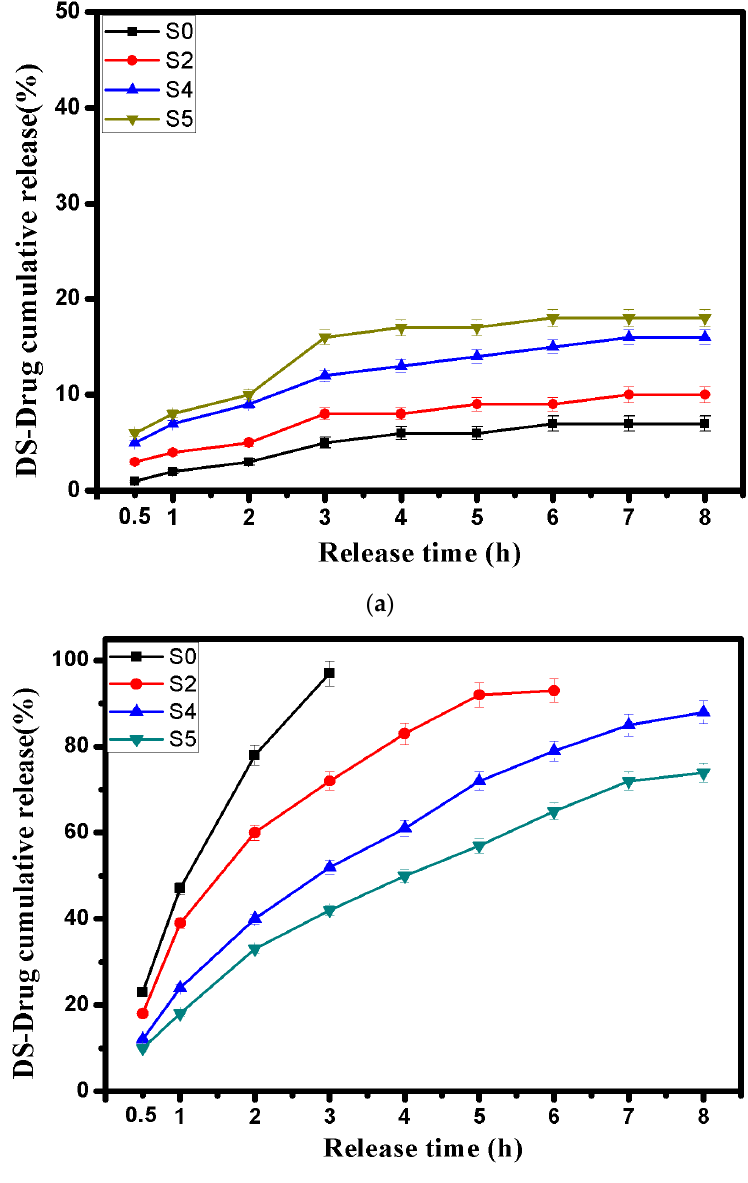
Figure 6. DS-drug release profiles for Alg (S0), Alg-CMCs single PEC (S2) and Alg-CMCs@AmCs dual PECs (S4 and S5) microcapsules at ( a ) pH1.2 and ( b ) pH 7.4. Values were presented as means ± S.D ( n = 3), and significant data were determined at p -value ≤